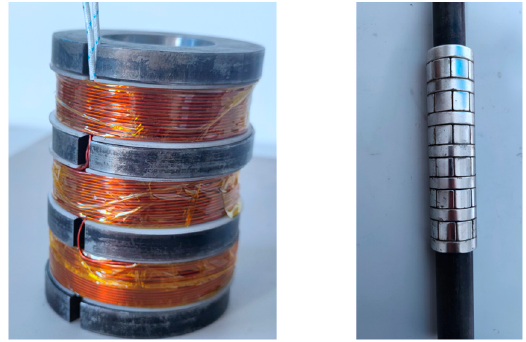
Figure 8. Winding unit and Halbach array of PMLG.